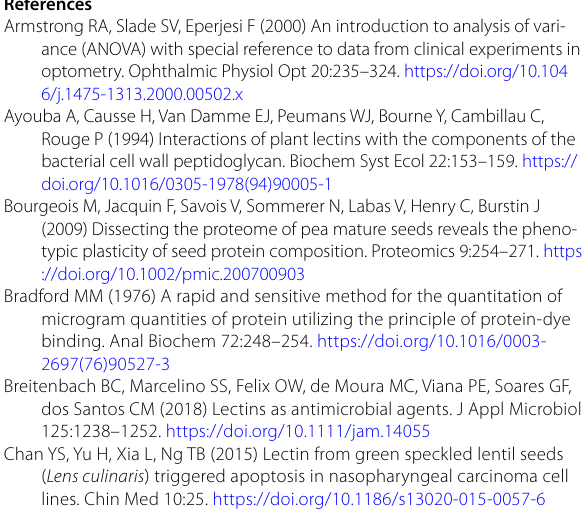
( Lens culinaris ) triggered apoptosis in nasopharyngeal carcinoma cell lines. Chin Med 10:25. https ://doi.org/10.1186/s1302 0‑015‑0057‑6